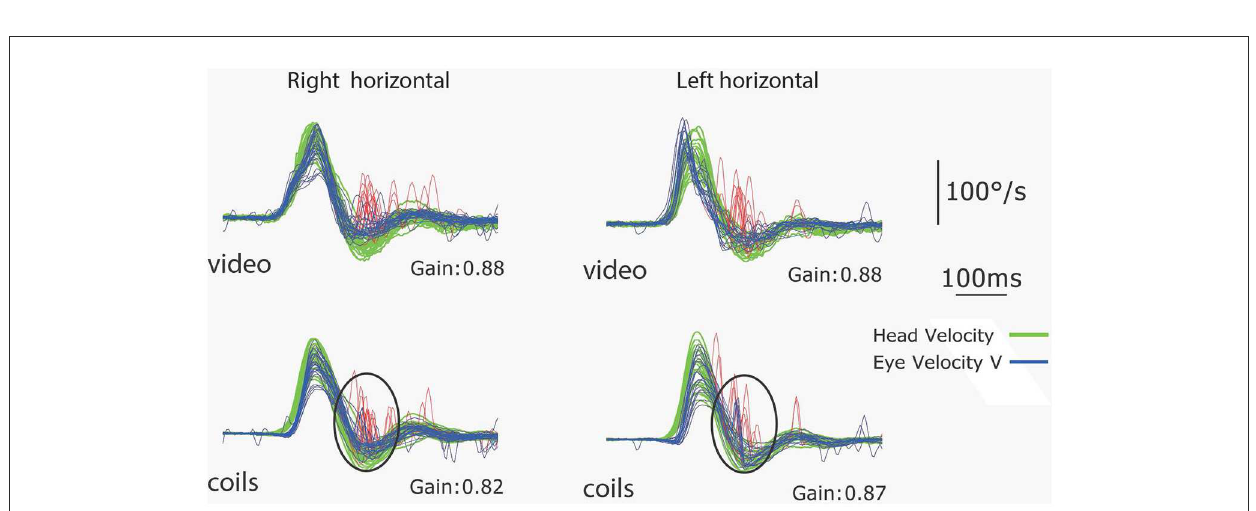
FIGURE15 Simultaneous coils and vHIT recordings of the responses of a healthy subject to leftwards and rightwards horizontal head impulses. The VOR gains are in the normal range ( > 0.8) but this subject makes small saccades (microsaccades) at the end of the impulses which are clear on both video and coils records and are circled on the coils records. This is an example of a subject with normal VOR gain but small corrective saccades [Reproduced from MacDougall et al. (9) with